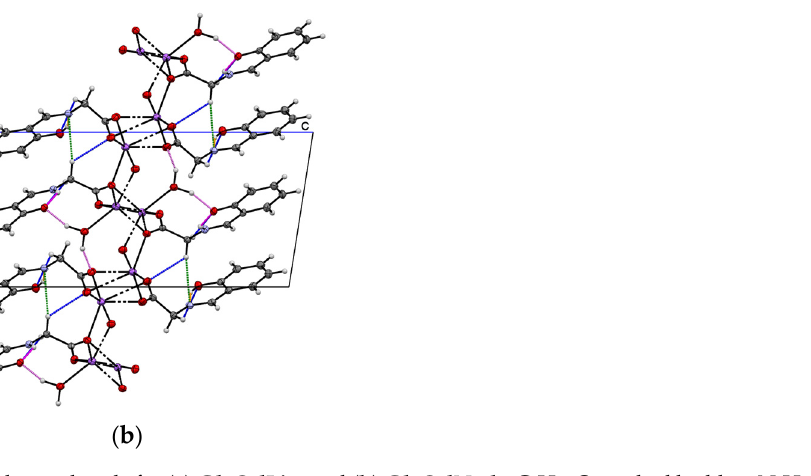
Figure 3. Hydrogen bonds for ( a ) GlySalLi-a and ( b ) GlySalNa-h . C-H ··· O marked by blue, N-H ··· O—by magenta, C-H ··· N—by green, O-H ··· N—by orange, O-H ··· O—by light violet, dashed lines.